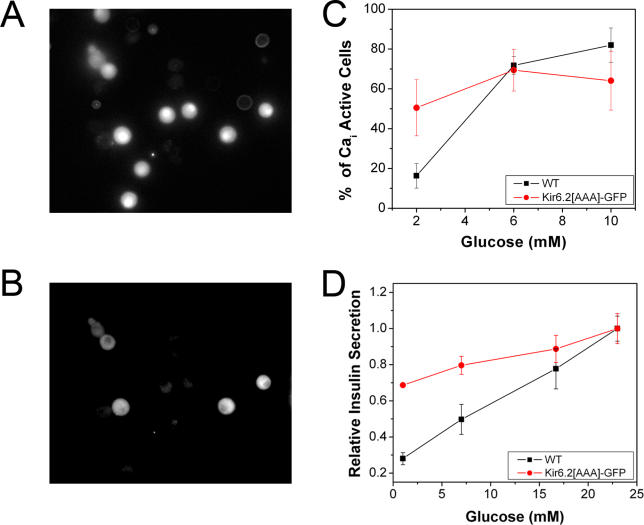
Dispersed Cell Cai and Insulin Responses(A) Dispersed Kir6.2[AAA] cells labeled with Fura-2 (340-nm image). These are mainly β-cells, with the expected minority of non–β-cells.(B) GFP image of the same field of view of (E). A fraction of cells (four of eight) are GFP positive.(C) The glucose-stimulated Cai response of dispersed cells from WT (black square) and Kir6.2[AAA] (red circle) islets measured using Fura-2 fluorescence microscopy. Kir6.2[AAA] cell preparations were a combination of GFP-labeled and non-labeled cells. The percentage of Cai-active cells was measured in 2, 6, and 10 mM glucose on three separate days in WT and Kir6.2[AAA] dispersed cells, respectively (mean ± standard error of the mean [SEM], n = 3). The WT cells show a strong glucose dependence, whereas the Kir6.2[AAA] cells show similar numbers of Cai active cells at all glucose concentrations.(D) Insulin secretion from dispersed WT and Kir6.2[AAA] cells (mean ± SEM, n = 4) from static 1-h incubations. This incubation time shows KATP channel–dependent insulin secretion, but does not encompass KATP channel–independent insulin secretion shown to occur in knockout islets beyond 3 h of incubation [13]. The difference in means ± 95% confidence interval for (C) and (D) are shown in Figure S2B and S2C, respectively).